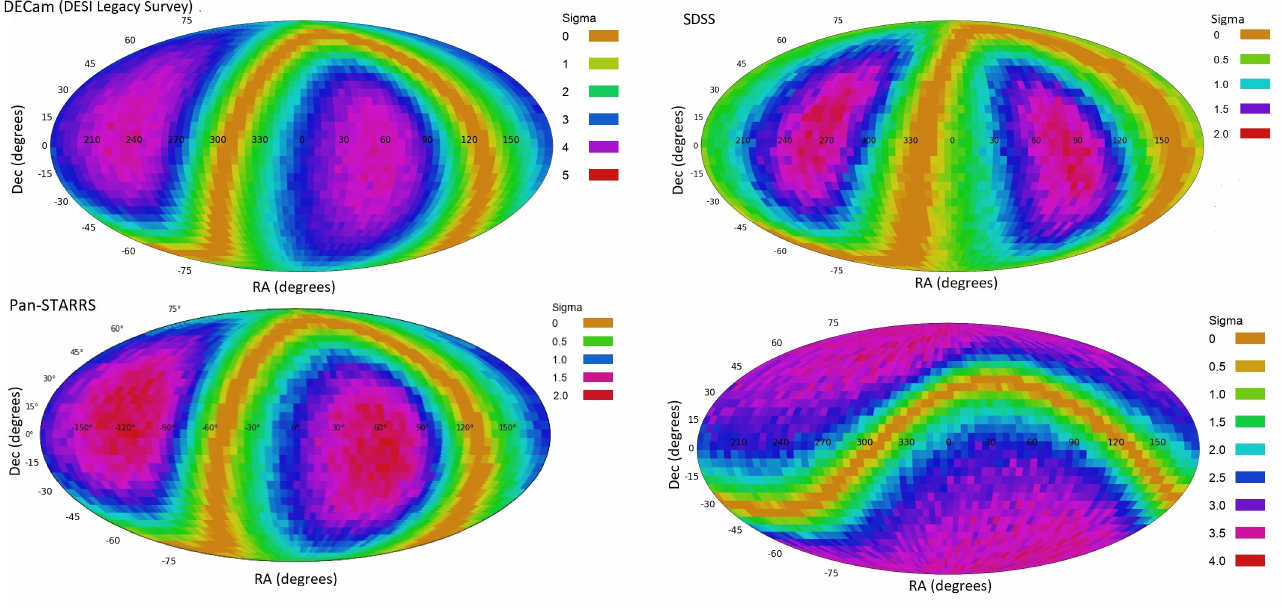
Figure 6. The statistical significance of a dipole axis in galaxy spin directions from different ( α , δ ) combinations of SDSS, Pan-STARRS, DESI Legacy Survey, and DES. The SDSS galaxies are a subset selected such that the redshift distribution of the galaxies in that subset is similar to the distribution of the redshift in the DECam